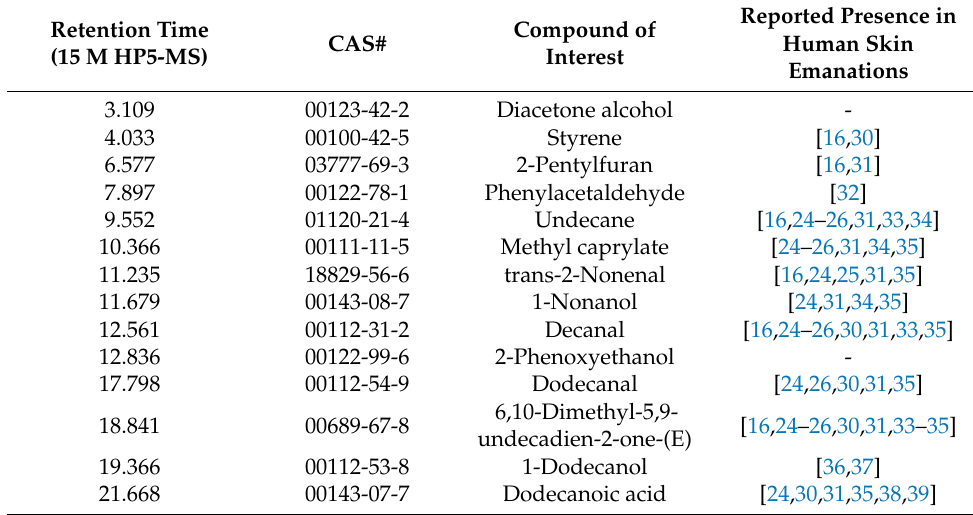
Table 2. Compounds contributing to the discrimination of SARS-CoV-2 infection. Retention